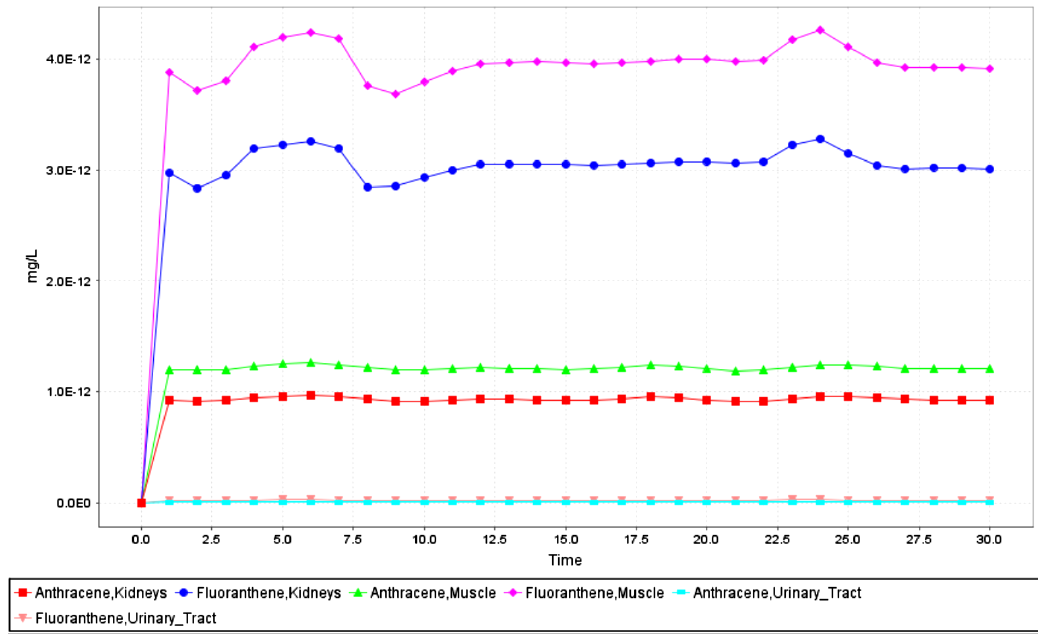
Figure 12. Pb concentration in the most contaminated compartments in subject 1, E group (logarithmic scale in y axis).